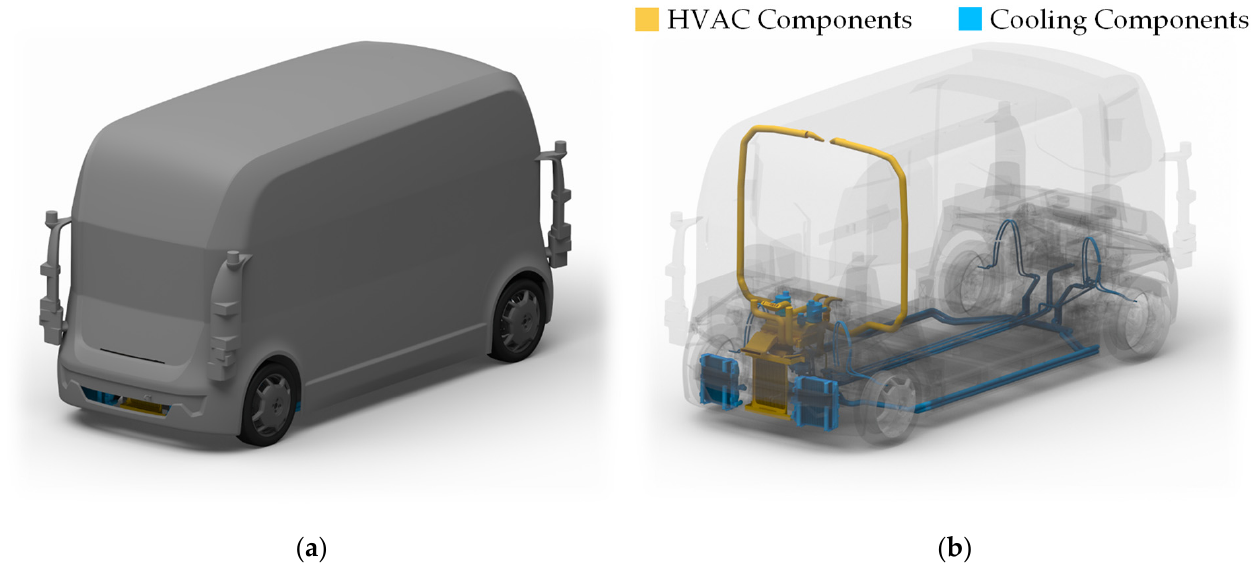
Figure 2. ( a ) Isometric view of the large vehicle variant (autoSHUTTLE); ( b ) vehicle package with HVAC and cooling components highlighted.